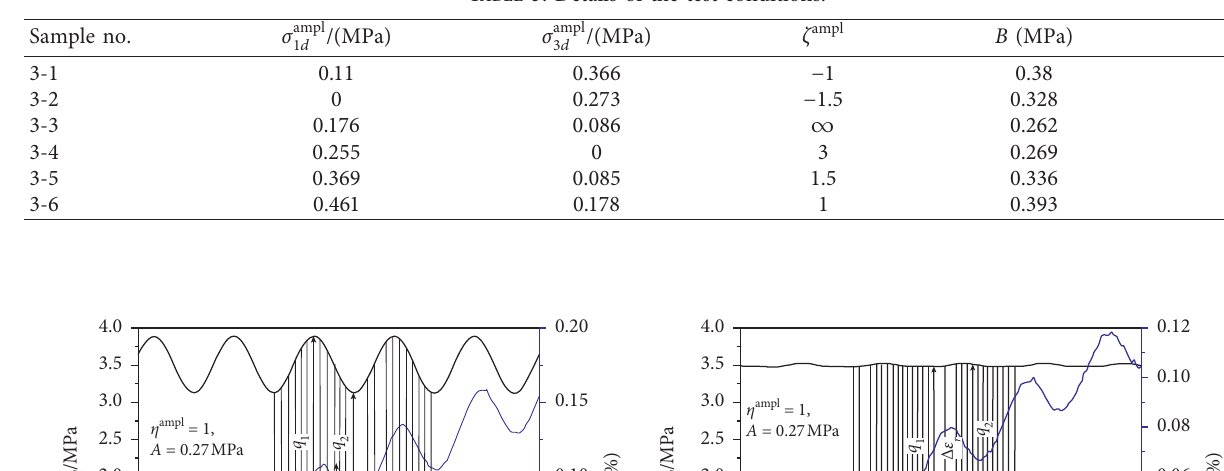
Table 3: Details of the test